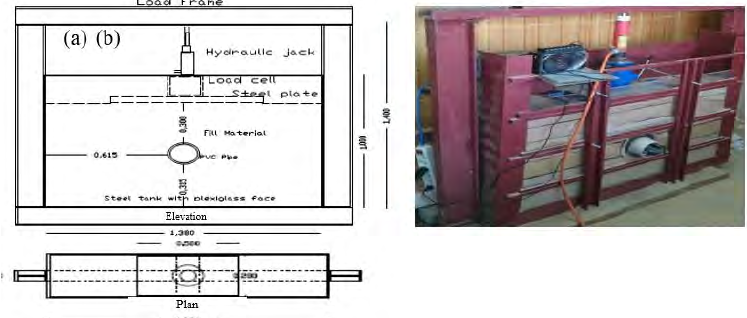
Figure 1. (a) The sketch diagram with dimensions of the model and (b)the loading frame and steeltank